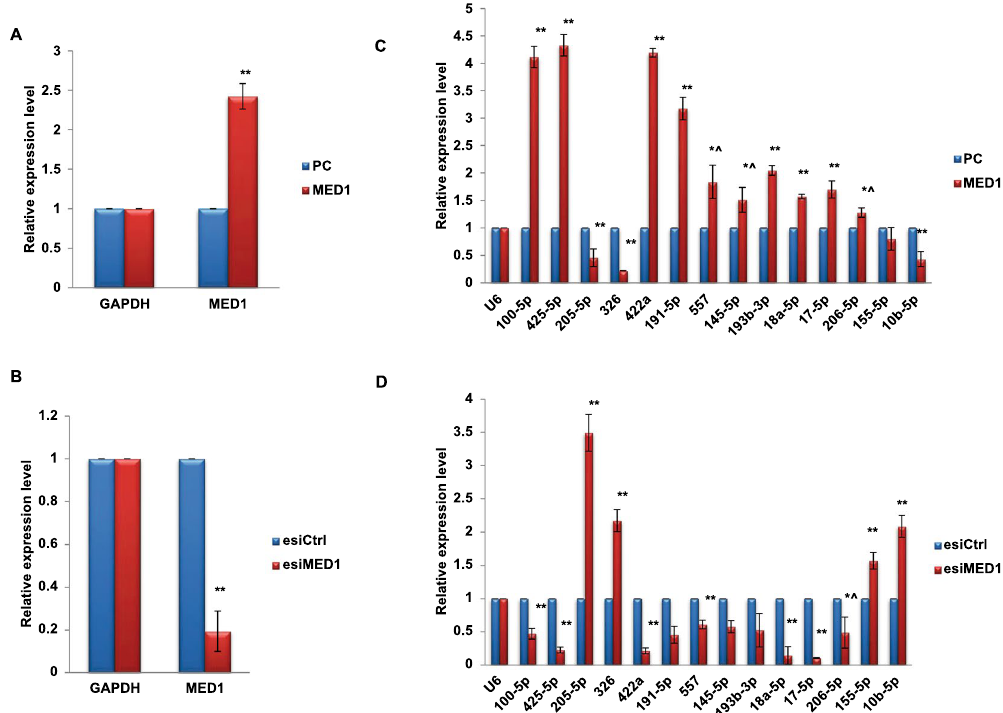
Figure 2. MED1 is involved in the regulation of miRNAs in breast cancer. Confirmation of overexpression/ inhibition of MED1 transcript in MCF7 cells. MED1 was transiently up/downregulated by transfecting MCF7 cells with pCDNA3.1-MED1 (MED1) or pCDNA3.1 (PC) and esiMED1/esiCtrl. The corresponding effect on MED1 transcript levels in response to MED1 overexpression ( A ) or downregulation ( B ) was then checked by qRT-PCR and compared to that of their respective controls in MCF7 cells. ( C , D ) MED1 was overexpressed ( C ) or inhibited ( D ) in MCF7 cells and stem loop qRT-PCR was done to check the levels of various breast cancer related miRNAs. The mRNA data was normalized to GAPDH and miRNA data was normalized to U6 small RNA. The graphical data points represent mean + S.D of at least three independent experiments ( ** P < 0.05, * P < 0.1). Error bars denote +